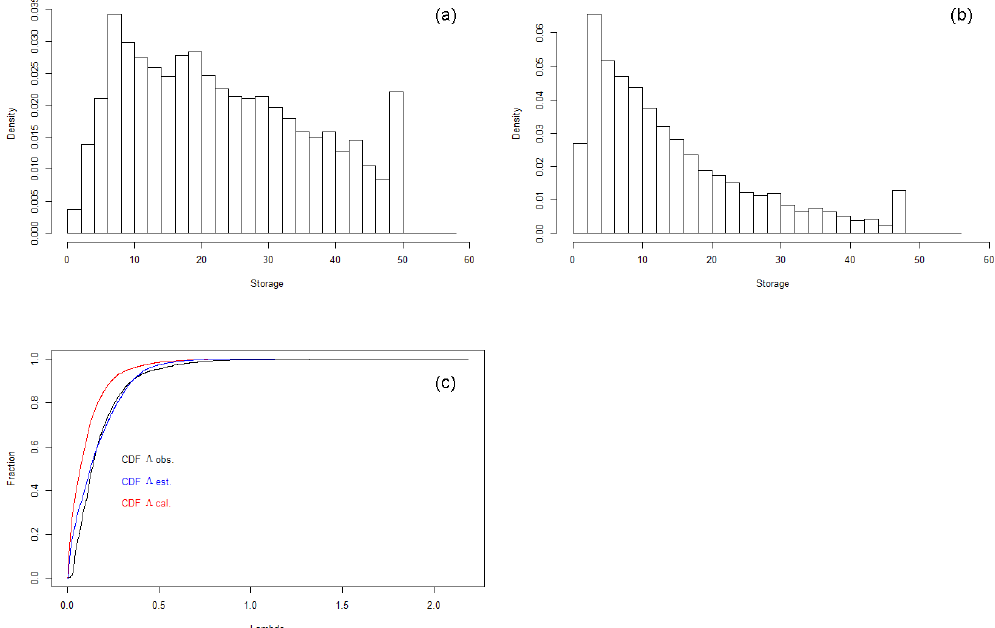
Figure 9. Histograms of storage simulations with DDD_ θ M (a) and DDD_ m S (b) . Empirical CDFs of observed (cid:51) (black line) and simulated ˙ (cid:51) with DDD_ θ M (red line) and DDD_ m S (blue line) are shown in (c) .